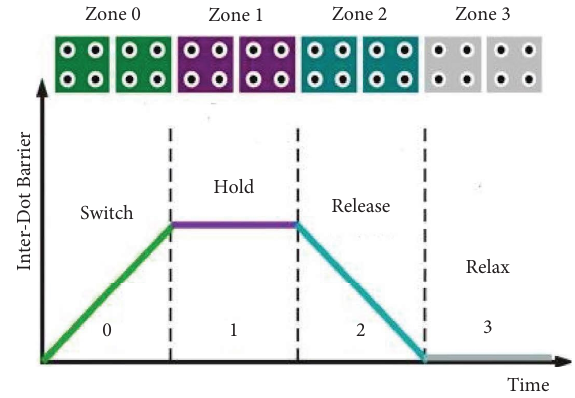
Figure 6: QCA clocking